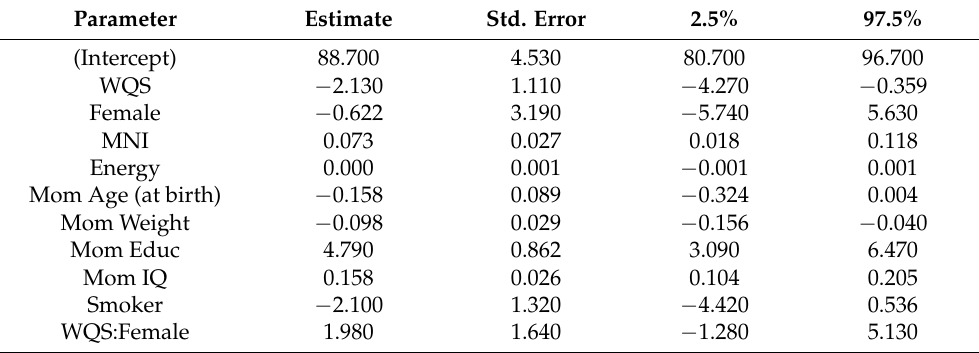
Table 2. Parameter estimates (mean, standard error, 2.5 percentile, 97.5 percentile) from WQS sex- stratified interaction regression across 100 holdout datasets. The slope associated with WQS is for males; the interaction between WQS and sex is the difference in slopes between boys and